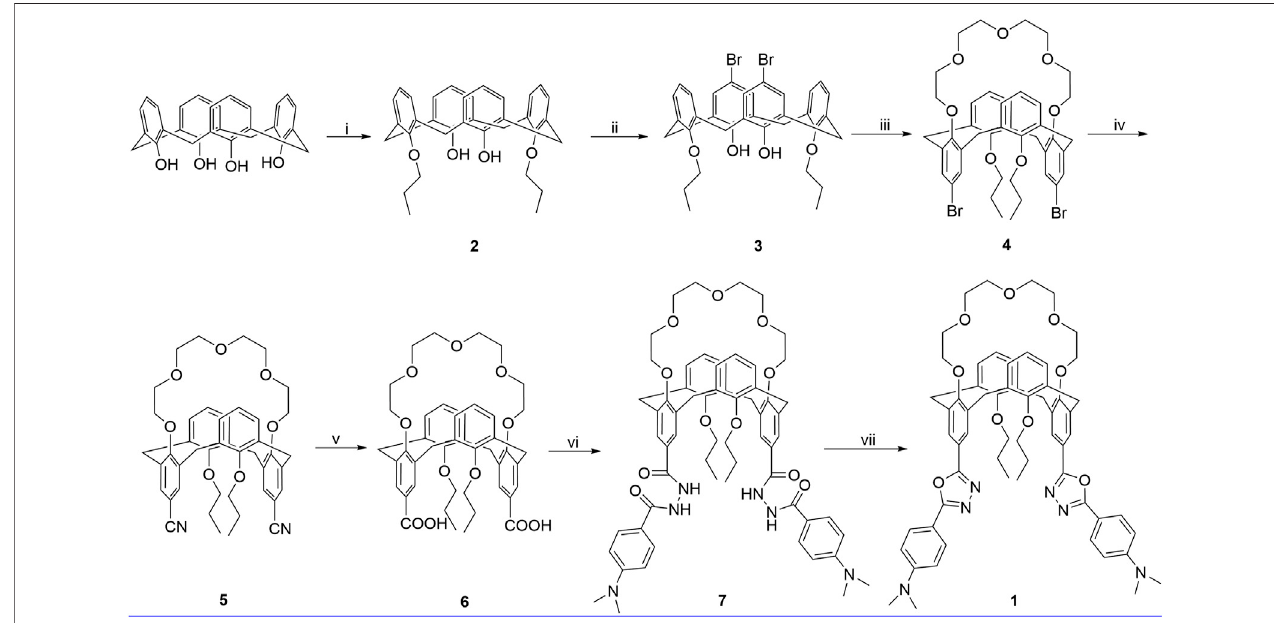
SCHEME 1 | Synthetic route for 1 , reagents, and conditions: (i) 1-iodopropane, K 2 CO 3 , CH 3 CN, re fl ux, 24 h; (ii) Br 2 , 0 ° C, 3 h; (iii) tetraethylene glycol ditosylate,